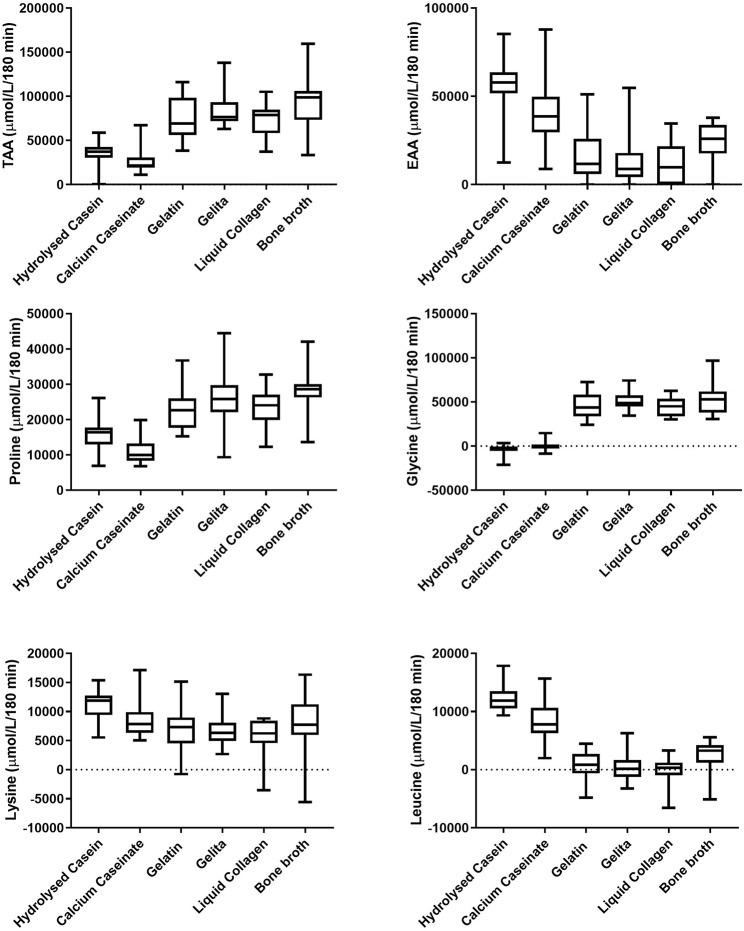
Area under the concentration—time curve (AUC) of plasma amino acids over 180 min after the consumption of dairy and collagen protein sources. Middle line shows mean, boxes represent 25–75th percentile and whiskers represent min and max values.